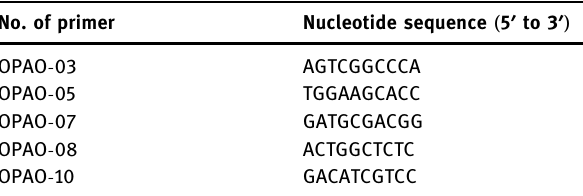
Table 2: The sequence of the RAPD primers used in the study No. of